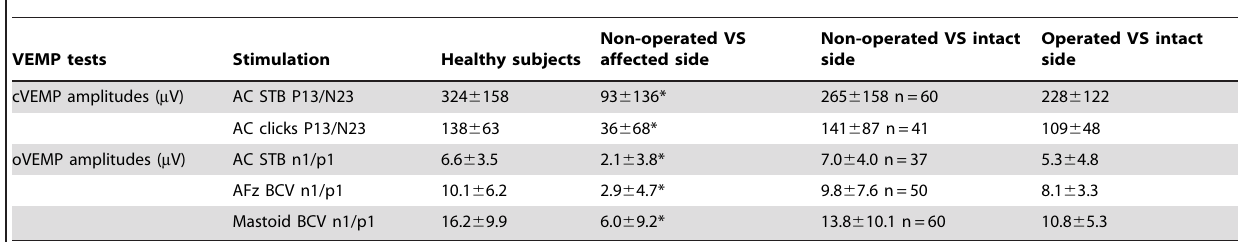
Table 1. Means ( 6 SD) peak-to-peak amplitude of cVEMPs induced by AC STB and clicks, and mean ( 6 SD) peak-to-peak amplitude of oVEMPs induced by AC STB and BCV (AFz and mastoid), in healthy subjects, 63 patients with non-operated VS (affected and intact side) and 20 patients after surgery for VS (intact side).